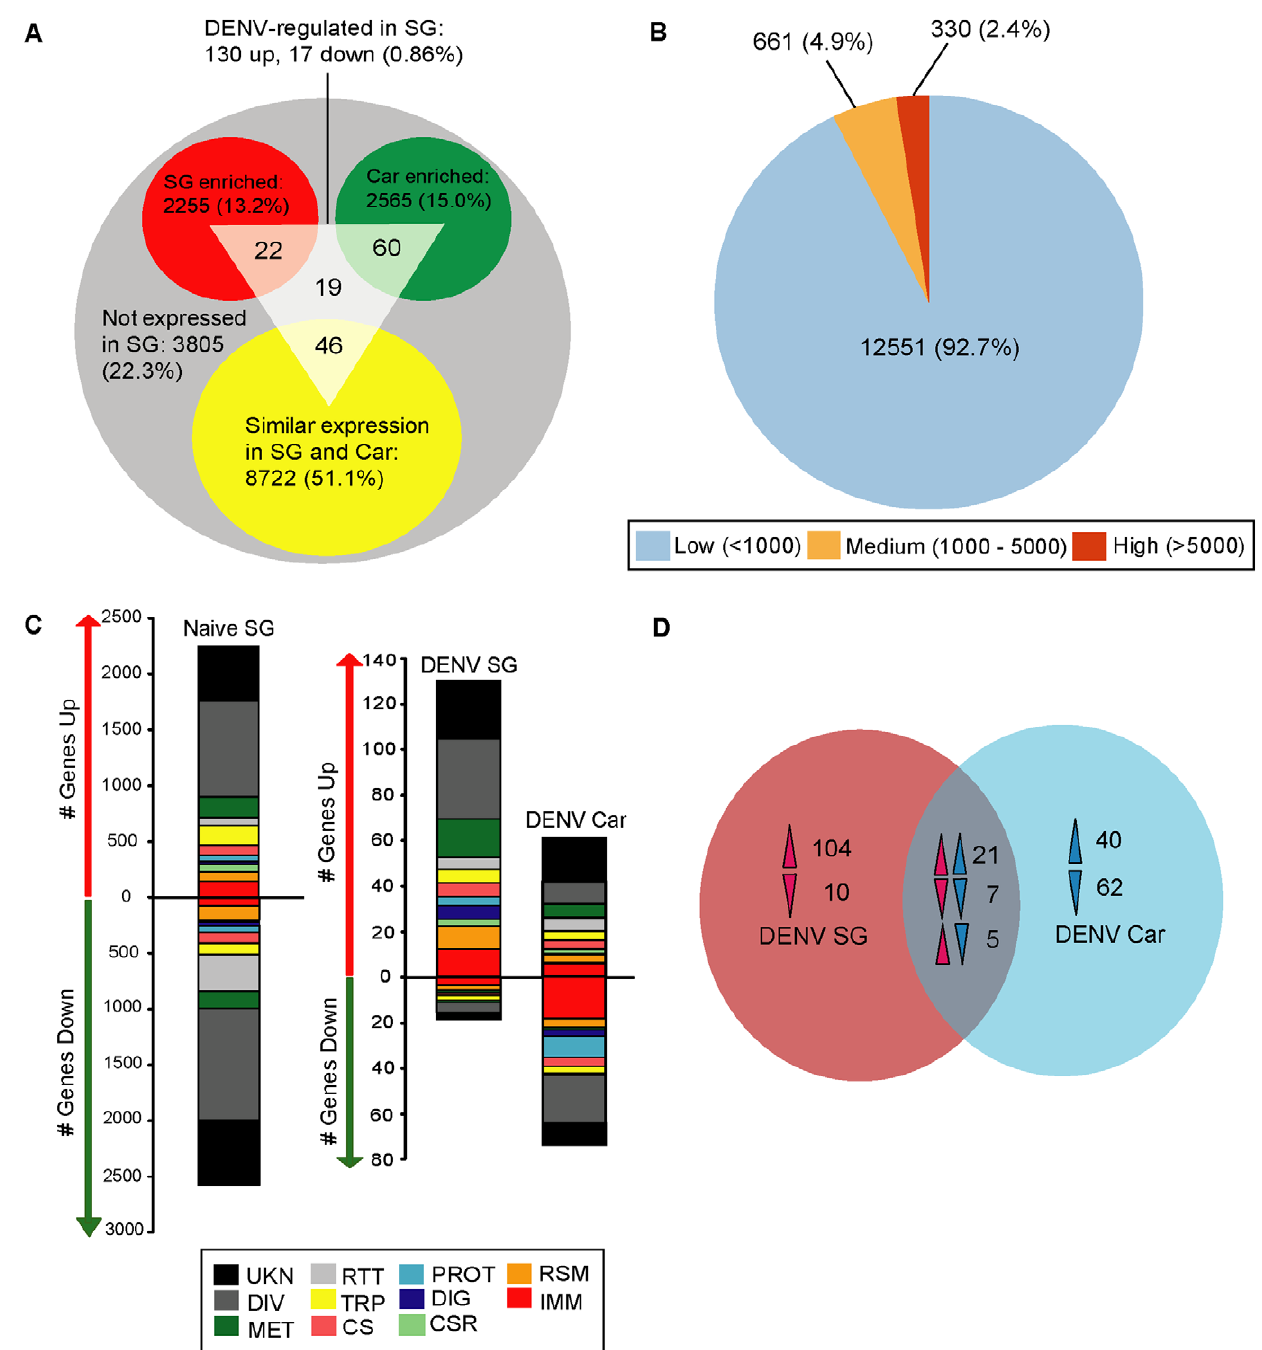
Figure 1. Microarray gene expression analysis of the naı¨ve and DENV-infected salivary gland transcriptomes. ( A ) Numbers of genes that displayed differential (red and green circles) and similar (yellow circle) transcript abundance between the naı¨ve salivary gland and carcass. The superimposed gray triangle shows the numbers of genes displaying significant differences in transcript abundance in the DENV-infected salivary gland, and their overlap with genes expressed in the naı¨ve gland. ( B ) Salivary gland-expressed genes were classified into low, medium and high abundance categories according to their spot intensities on the array. The pie chart shows the number of genes in each category and its corresponding percentage of the total number of expressed genes. ( C ) Functional classification of differentially expressed genes in the naı¨ve salivary gland (relative to the carcass), the DENV-infected salivary gland, and the DENV infected carcass. Functional group abbreviations: CS, cytoskeletal and structural; CSR, chemosensory reception; DIV, diverse functions; DIG, blood and sugar food digestive; IMM, immunity; MET, metabolism; PROT, proteolysis; RSM, redox, stress and mitochondrion; RTT, replication, transcription, and translation; TRP, transport; UKN, unknown functions. ( D ) Venn diagram showing numbers of uniquely and commonly regulated genes in DENV-infected salivary glands and carcasses. Arrows represent the direction of gene regulation.